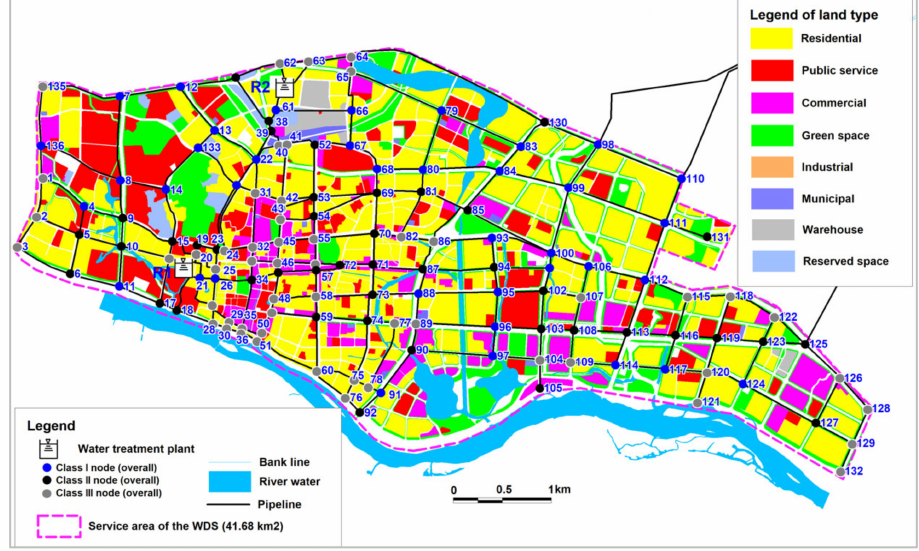
Figure 10. Land types in the service area of WDS in Z city and the overall importance of user